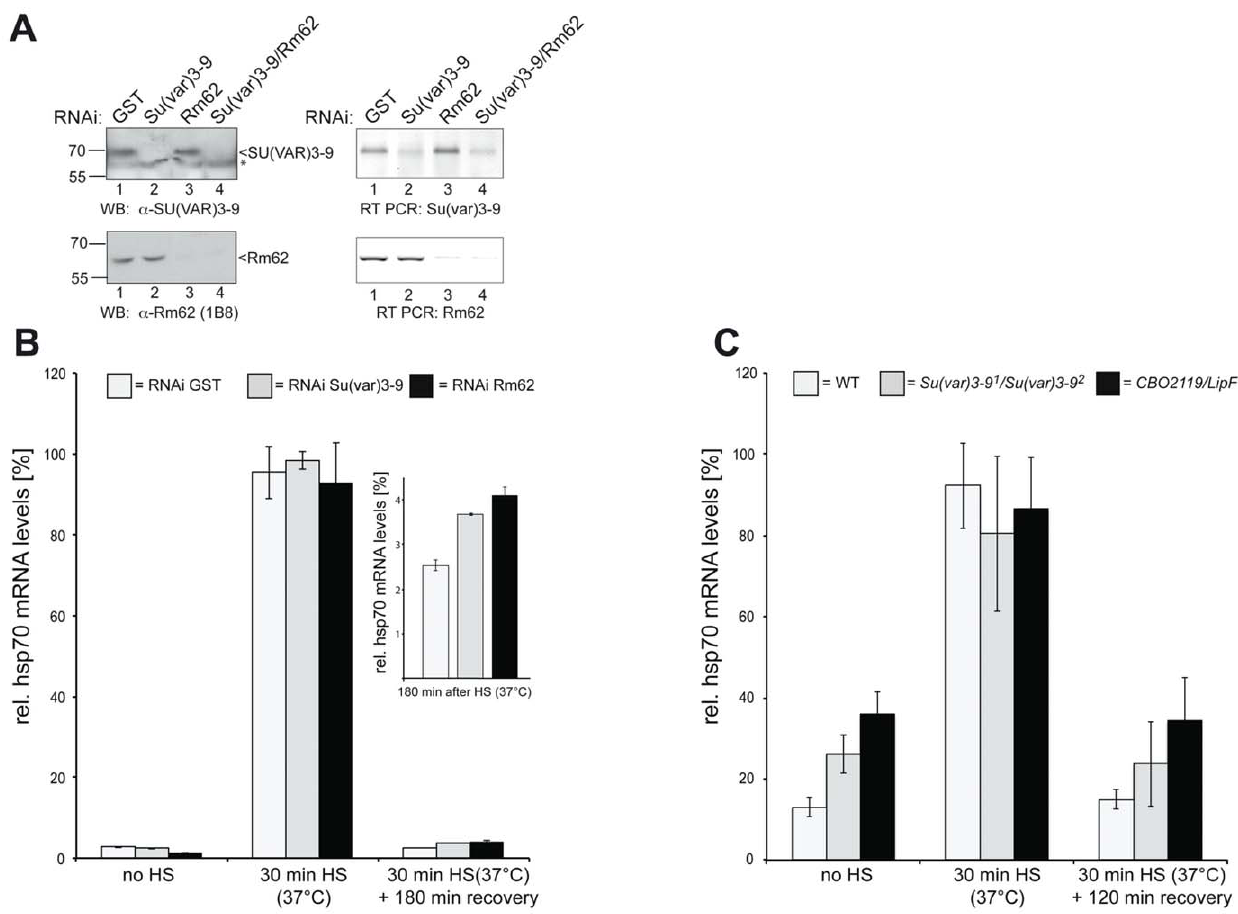
Figure 3. Prolonged RNA production from the hsp70 locus after reduction of SU(VAR)3-9 or Rm62. ( A ) RNAi against SU(VAR)3-9 and/or Rm62 specifically eliminates the respective proteins as well as it’s mRNA from SL2 whole cell extract (WCE). SL2 cells were transfected with specific double stranded RNAs against SU(VAR)3-9, Rm62 or GST (control). WCEs and total RNA were prepared 6 days after transfection. Left : Proteins were analyzed by SDS-PAGE followed by western blotting with the indicated antibodies (GST: control RNAi, SU(VAR)3-9: RNAi against Su(var)3-9, Rm62: RNAi against Rm62, SU(VAR)3-9/Rm62: double knockdown of Su(var)3-9 and Rm62). Right : 1 m g oft total RNA, was reverse transcribed (Superscript TM , Reverse Transcriptase, Invitrogen) using gene specific primers for Su(var)3-9 or Rm62, respectively. 10% of the obtained cDNA were analyzed by standard PCR using specific primers for Su(var)3-9 or Rm62, and separated by agarose gel electrophoresis. To discriminate between genomic and cDNA, we used intron spanning primer pairs in the PCR reaction. ( B ) Quantitative RT-PCR of the hsp70 m RNA from SL2 cells before (no HS), after heat shock (30 min HS) and a 180 min of recovery phase ( + 180 min recovery). SL2 cells, cultured under standard conditions, were subjected to RNAi against GST (control), Su(var)3-9 or Rm62. After 6 days of culturing, cells were either not treated (no HS) or treated with a heat shock (30 min HS) followed by a recovery for 180 min at 26 u C ( + 180 min recovery), respectively. RNA from these cells was isolated, reverse transcribed and analyzed by quantitative real time PCR. Bars represent relative hsp70 RNA expression levels (in percent) normalized to an internal control (U6 snRNA), which does not respond to heat shock. Percent expression was calculated to the maximal amount of RNA measured after heat shock. The inlet graph shows an enlargement of the calculated values after 180 min recovery upon heat shock. The observed difference between the SU(VAR)3-9/GST and Rm62/GST is significant as calculated with an unpaired two sided Student’s t-test (p=0.041 and p=0.014, respectively). Error bars indicate the standard deviation of two replicates. ( C ) Relative expression of hsp70 RNA from wild type (WT) Rm62 ( CBO2119/LipF ) and Su(var)3-9 heteroalleic flies ( Su(var)3- 9 1 /Su(var)3-9 2 ) before (no HS) or after heat shock (30 min HS) followed by 120 min of recovery ( + 120 min recovery). RNAs were extracted from the flies either not treated or treated with a heat impulse and ‘‘recovered’’ for 120 min at 25 u C and further subjected to quantitative real time PCR. Bars represent relative hsp70 RNA expression levels (in percent) normalized to an internal control (18S rRNA), which has a minimal effect on heat shock. The observed difference between Su(var)3-9 mutant and Rm62 mutants compared to wildtype flies is significant as calculated with an unpaired two sided Student’s t-test (p=0.047 and p=0.003, respectively). Error bars indicate the standard deviation of three replicates.